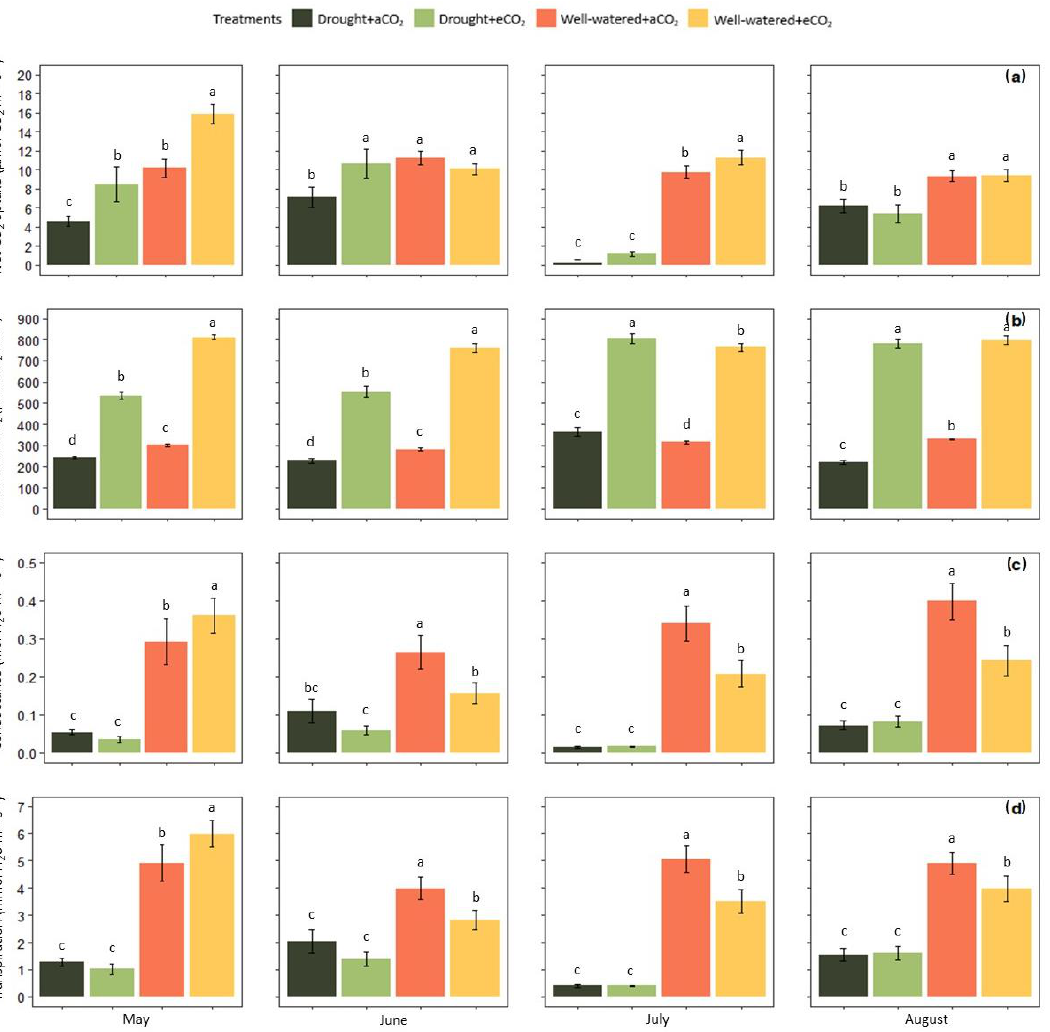
Figure 1. Effect of elevated CO 2 (950 ppm) and cyclic drought stress in the mean value ( ± confidential level of 95%) of Eucalyptus grandis ( a ) CO 2 uptake rates, ( b ) intercellular CO 2 concentration, ( c ) stom- atal conductance rates and ( d ) transpiration rates. Different small letters indicate statistical signifi- cance between the means ( p <